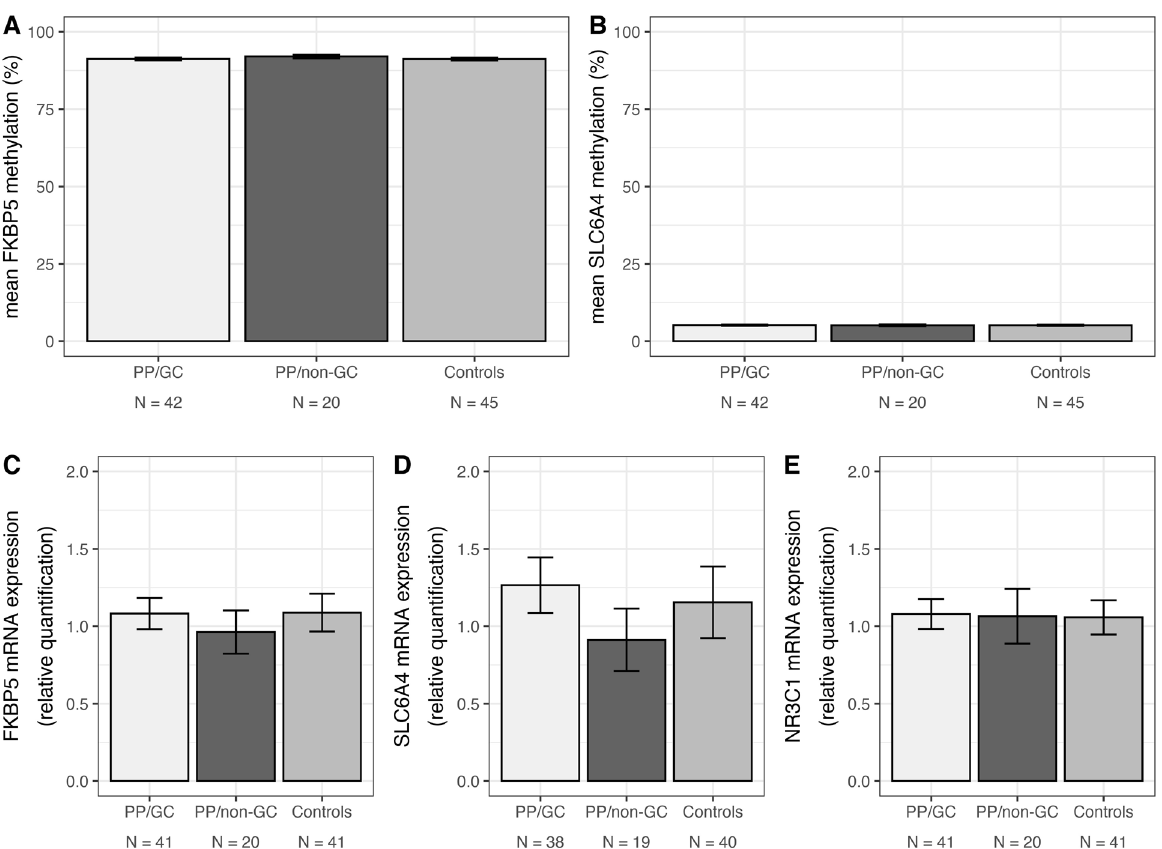
Fig. 1 Effects of antenatal sGC treatment on DNA methylation and mRNA expression. Upper part: There were no signi fi cant differences in mean DNA methylation levels between the three groups (pathological pregnancy group with antenatal synthetic glucocorticoid treatment (PP/GC), pathological pregnancy group without antenatal synthetic glucocorticoid treatment (PP/non-GC), untreated control group from physiological pregnancies). Data show mean with 95% con fi dence interval. A Mean DNA methylation of FKBP5 . B Mean DNA methylation of SLC6A4 . Lower part: There were no signi fi cant differences in mRNA expression levels between the three groups. C mRNA expression of FKBP5 . D mRNA expression of SLC6A4 . E mRNA expression of NR3C1